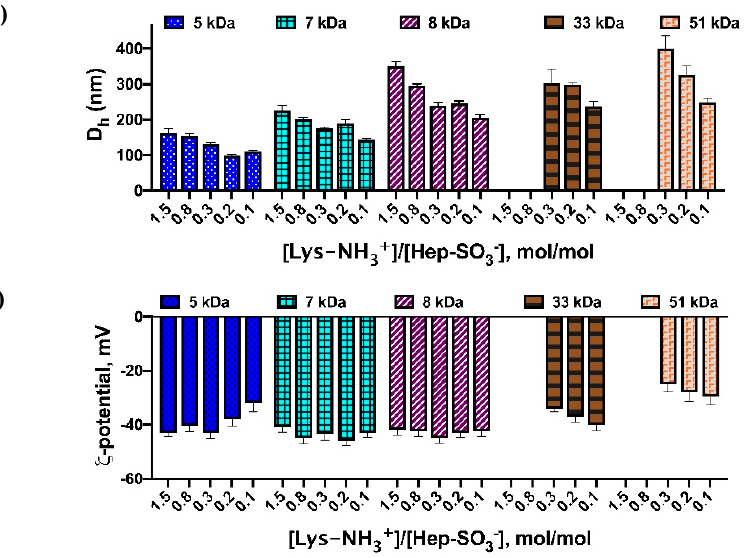
Figure 1. Characteristics of IPECs obtained at different PLL and Hep charged groups molar ratios and with application of PLL of different molecular weights: ( A ) particles hydrodynamic diameter; ( B ) particles ζ -potential.